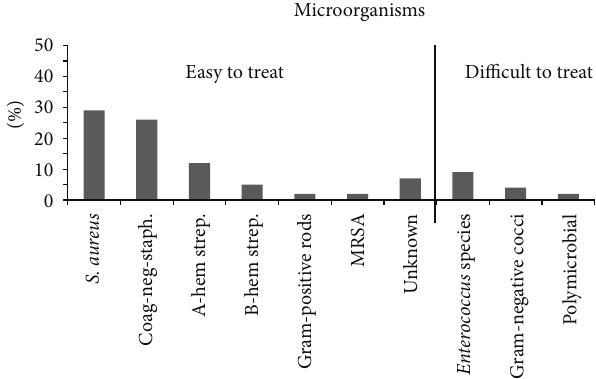
Figure 1: The percentage abundance of the encountered organisms in the cohort of this study. Coag-neg-staph: coagulase-negative staphylococci; A-hem strep: alpha-hemolytic streptococci. B-hem strep. Beta-hemolytic